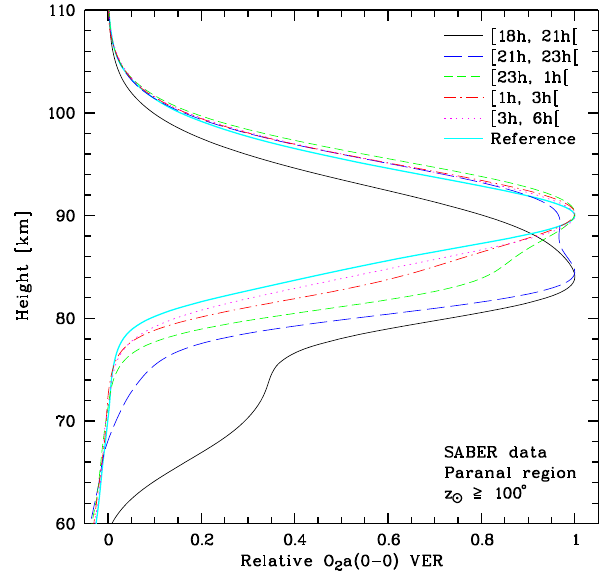
Figure 8. Mean emission profiles of different molecular transitions (see legend) for the Cerro Paranal SABER sample. The volume emission rates scaled to the emission peak are given as a function of the height in km. The emission peak height of the OH profiles in- creases with v (cid:48) and the mean profile of the 2.06µm SABER channel peaks higher than the 1.64µm one.